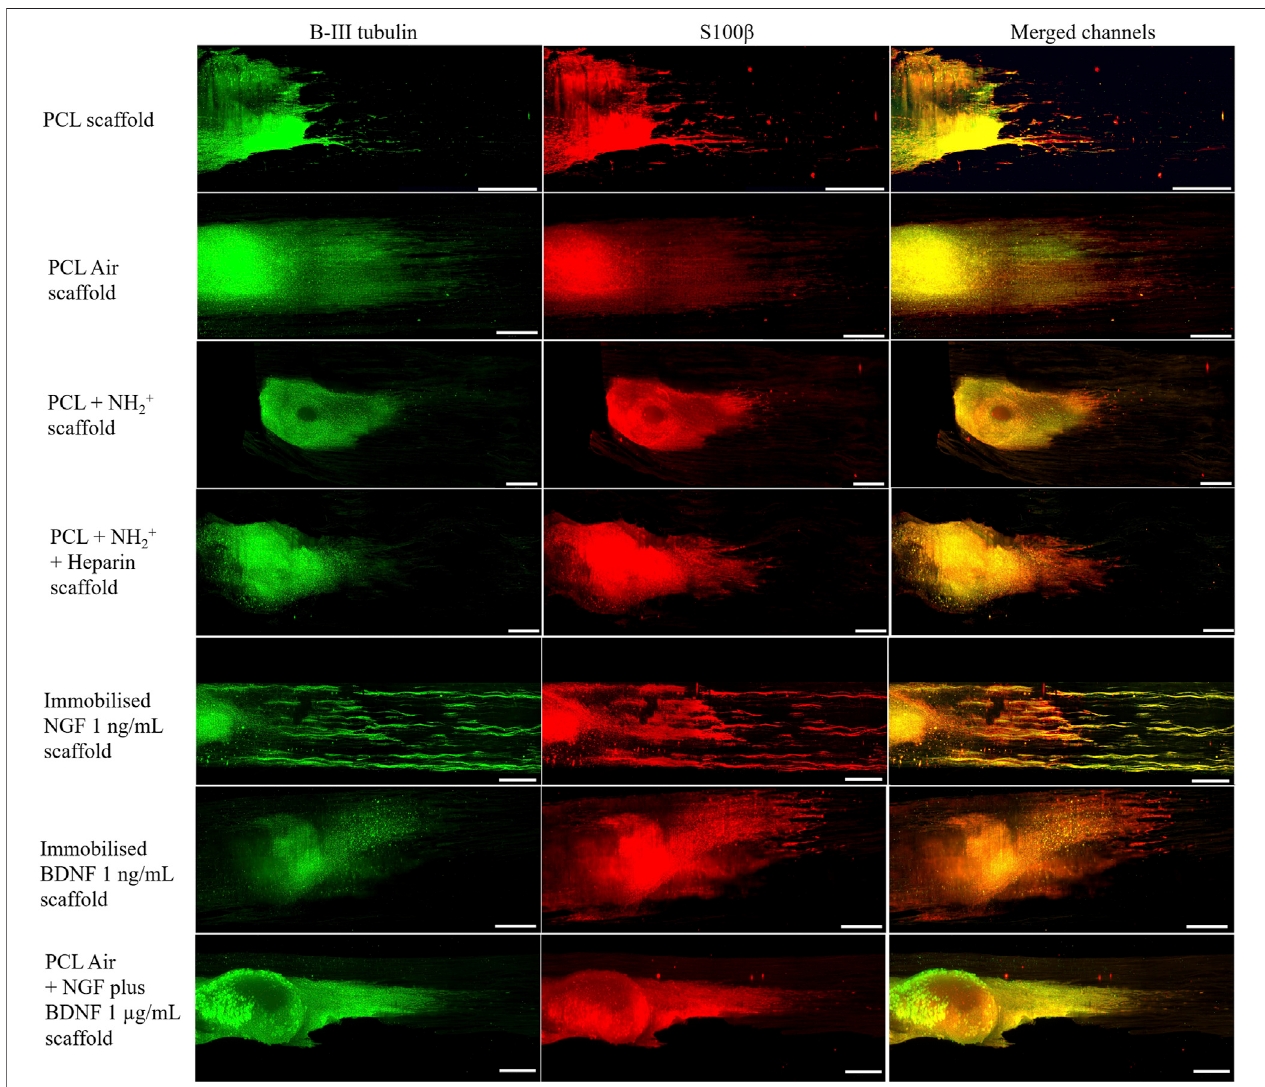
FIGURE5| DRGseededoncontrolPCLbioactivescaffolds:PCLscaffold,PCLairtreatedscaffold(PCLAirscaffold),PCL+NH 2+ scaffold,PCL+NH 2+ +Heparin scaffold, PCL + NH 2+ + Heparin + Immobilised NGF at 1 ng/ml scaffold, PCL + NH 2+ + Heparin + Immobilised BDNF at 1 ng/ml scaffold, and PCL air treated scaffold (PCL Air scaffold) with NGF plus BDNF at 1 µg/ml in culture medium. B-III tubulin protein in neurites stained in green. S100 β of Schwann cells stained in red. Merged channels are yellow, representing the co-localisation of growing neurites and Schwann cells. Scale bar (cid:2) 500 µm.